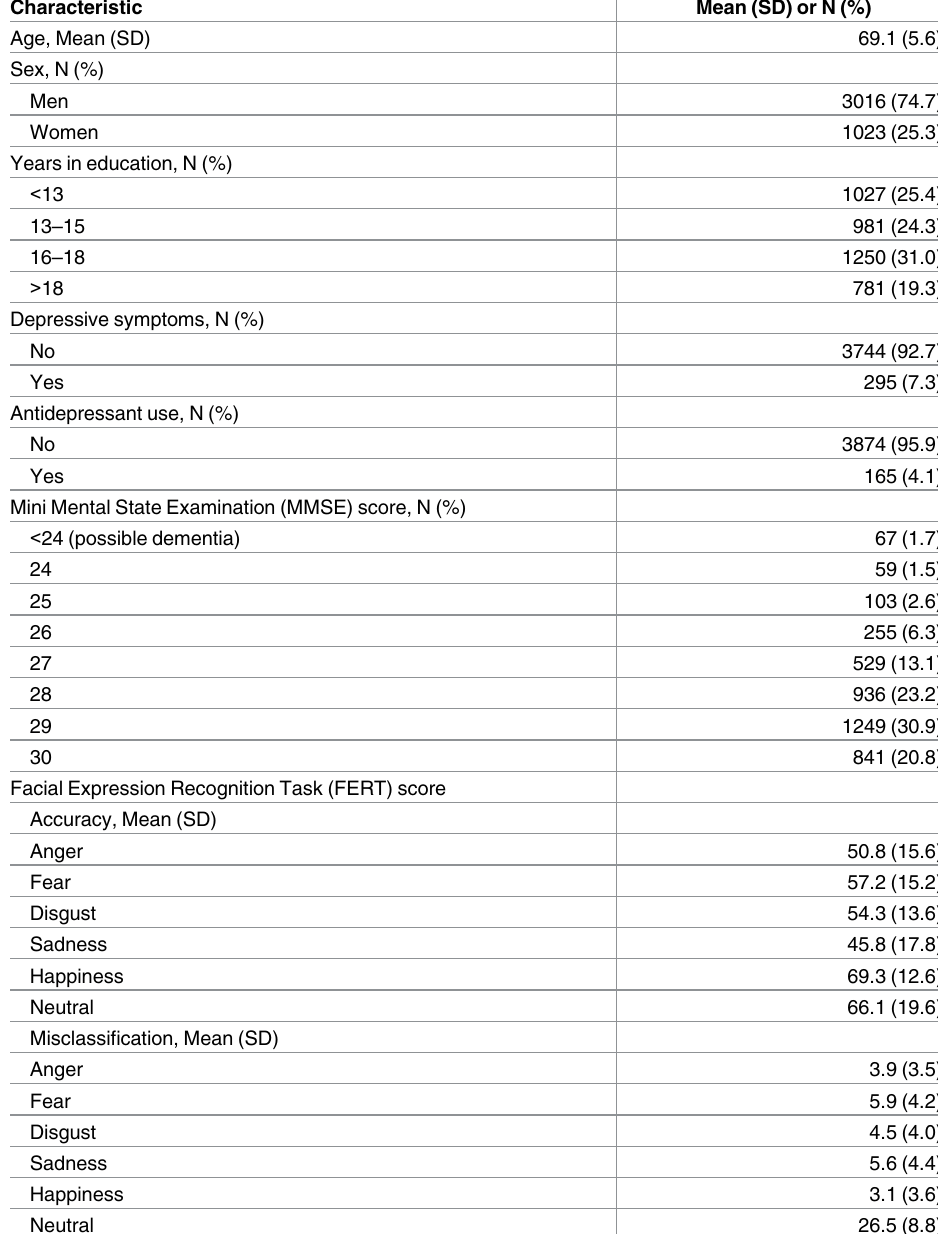
Table 1. Characteristics of the Whitehall II study participants (n =